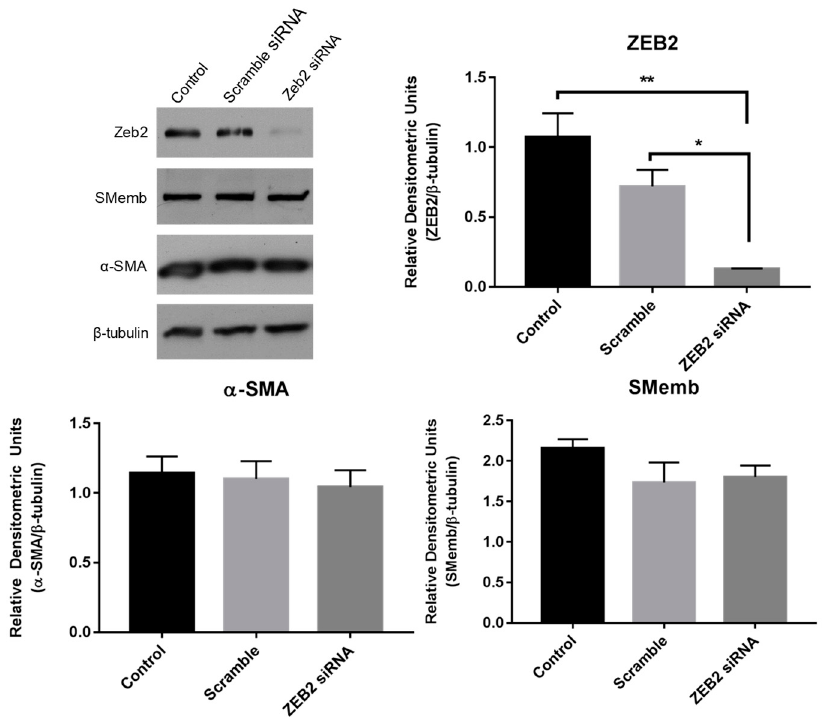
Figure 5. Zeb2 knockdown in primary cardiac myofibroblasts. First-passage (P1) rat cardiac myofibroblasts were subjected to 24 h of serum deprivation prior to treatment with 100 nM of either scramble or FITC-tagged Zeb2-targeted siRNA in serum-free, antibiotic-free DMEM. Untreated cells served as negative controls; transfection efficiency was verified by fluorescent microscopy. Data shown is representative of n = 3 biological replicates. ** p < 0.01, * p < 0.05.